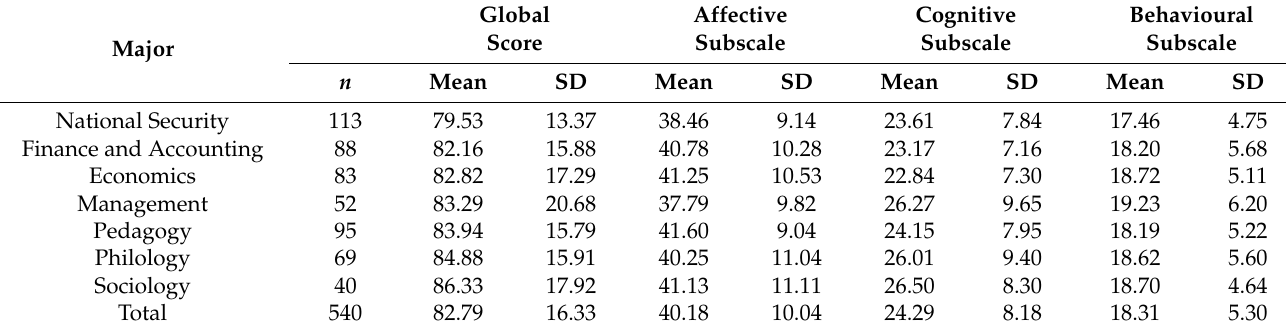
Table 5. MAS-PL scale results relative to the majors.